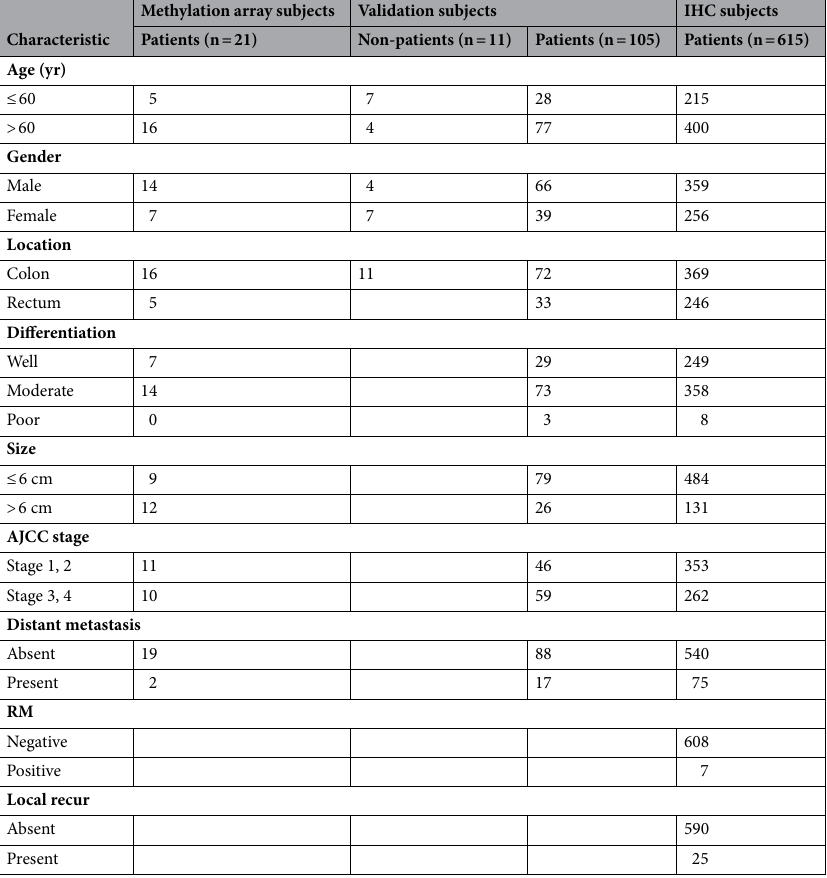
Table 3. Clinicopathologic characteristics of colorectal cancer patients. AJCC stage American Joint Committee on Cancer stage, RM resection